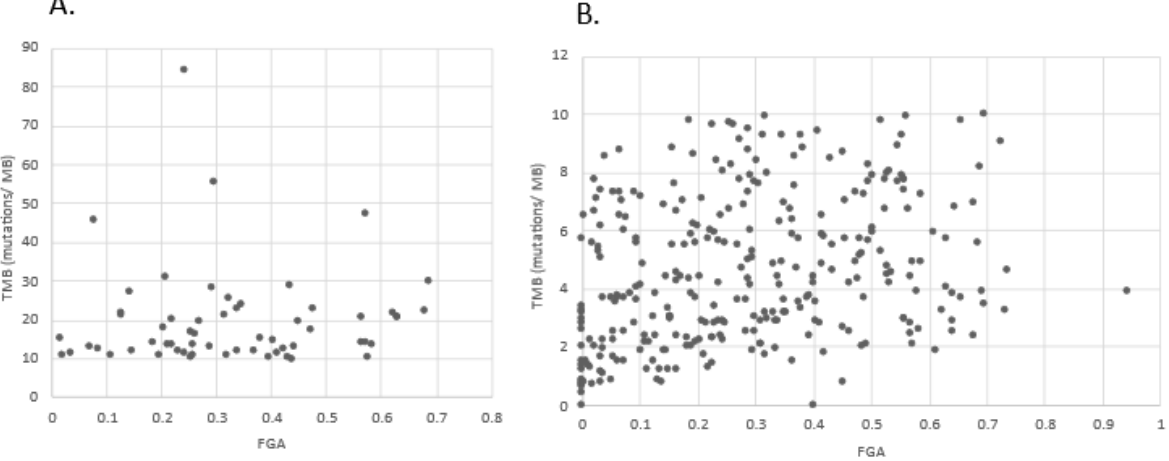
Figure 7. Correlation of TMB with chromosomal instability in: ( A ) The high TMB group ( n = 107) and ( B ) The low TMB group ( n = 298) of urothelial cancers in the TCGA cohort. FGA: Fraction Ge- nome Altered.